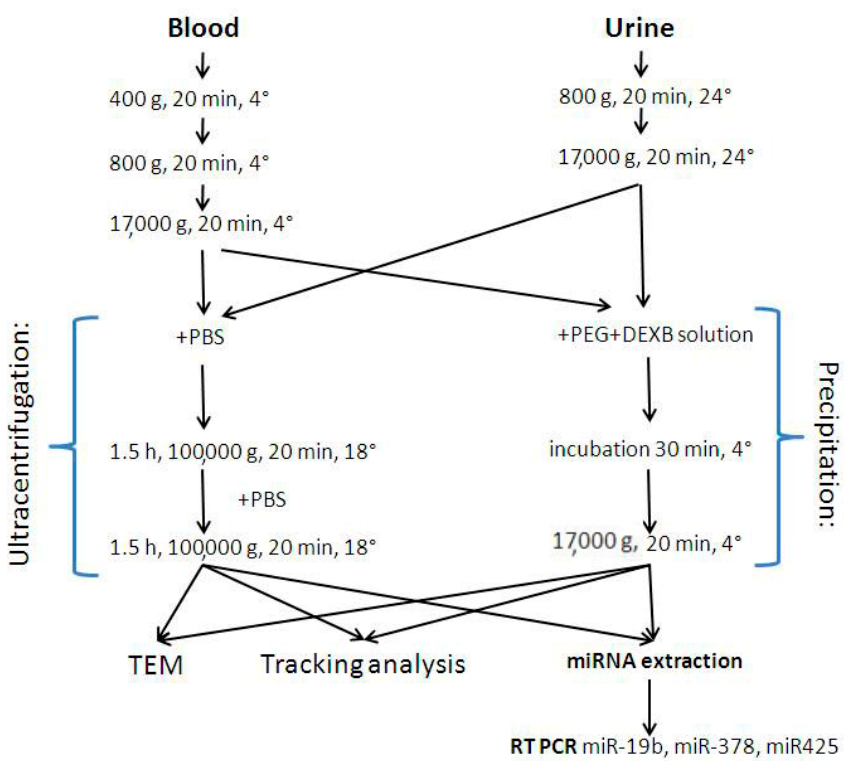
Figure 1. Scheme of the experiment.